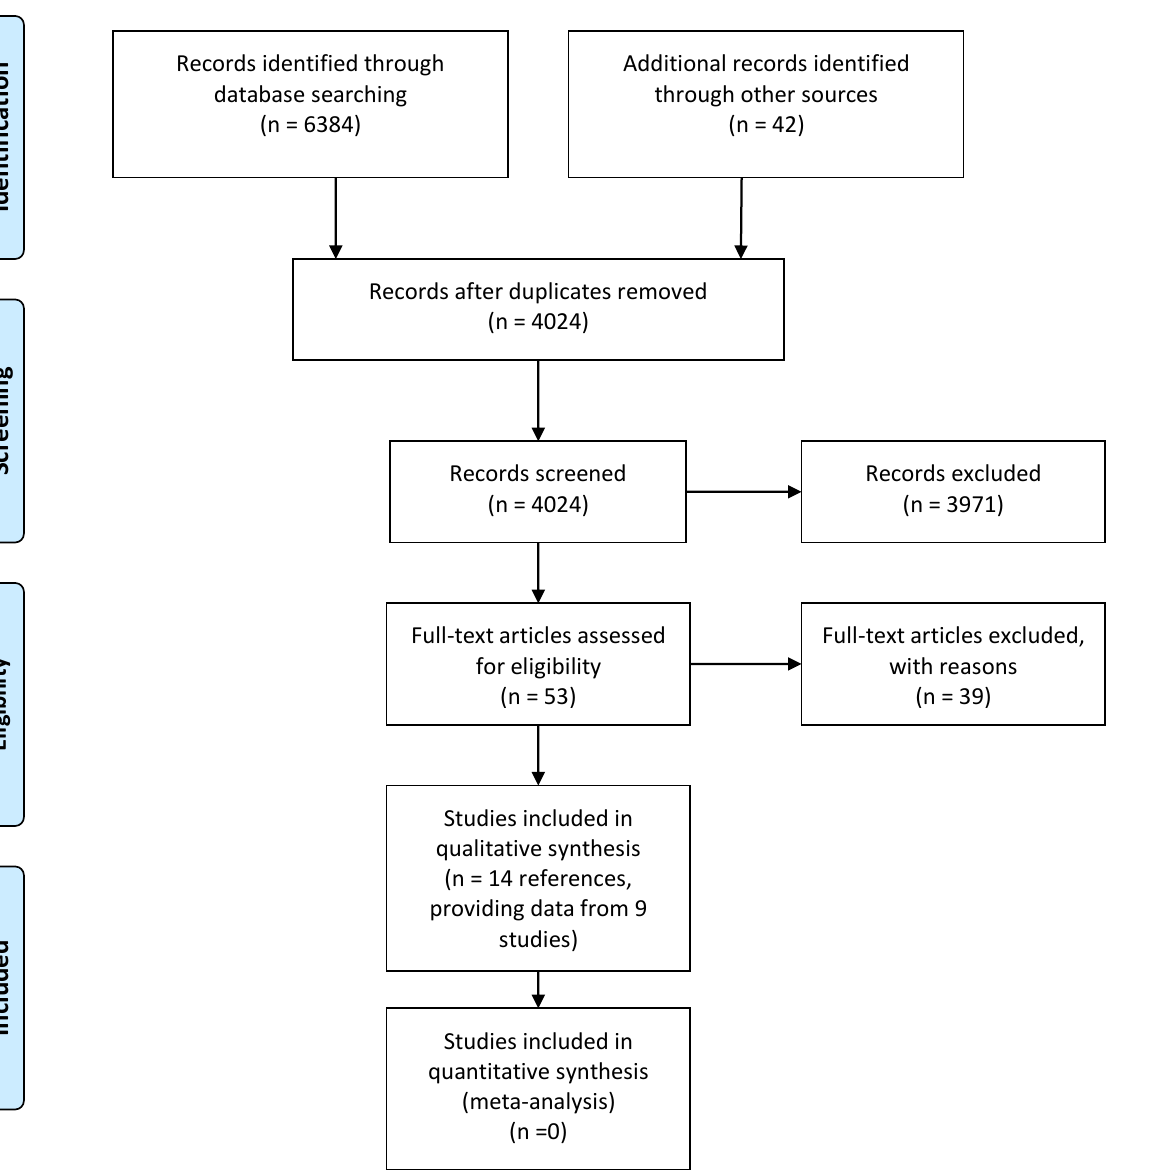
Figure 1. Preferred Reporting Items for Systematic Reviews and Meta-Analyses: The PRISMA